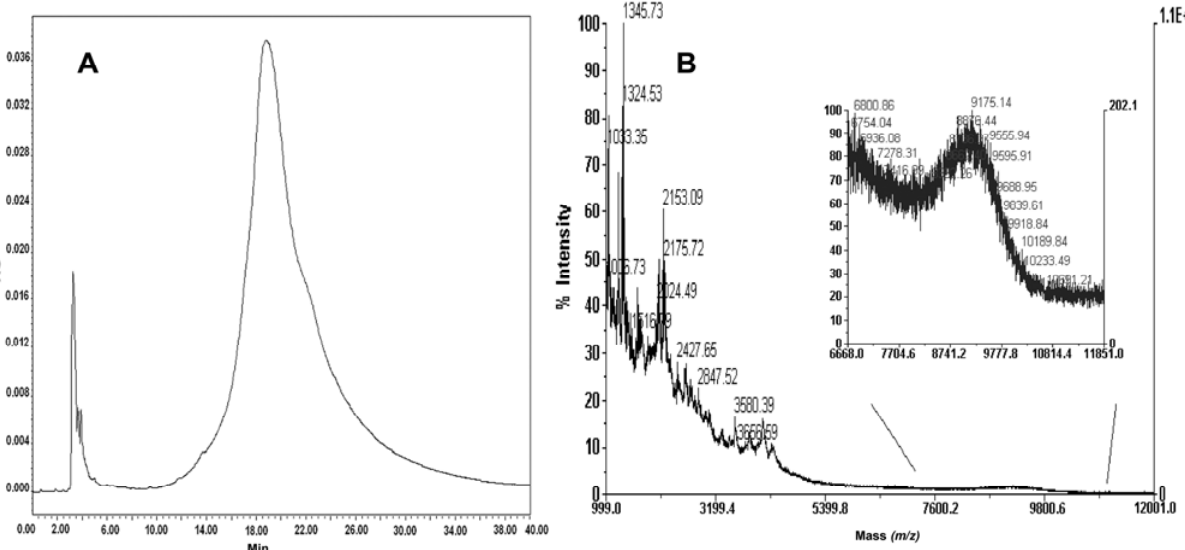
Figure 4. ( A ) RP-HPLC and ( B ) MALDI analysis of residue A PNA-PEG